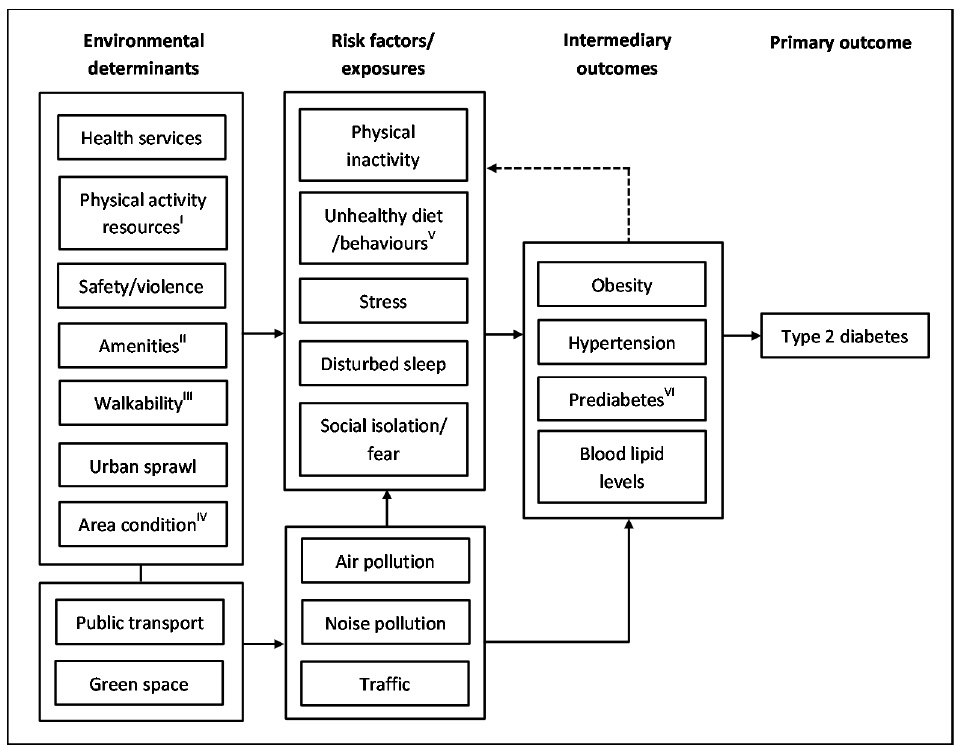
Figure 1. Schematic illustration of possible pathways through which environment impacts type 2 diabetes mellitus (T2DM) risk. Adapted from Poortinga [34], Northridge et al. [41], and Giles ‐ Corti et al. [42]. I include walking, jogging and cycling infrastructure, open spaces, trails, etc.; II include supermarkets, shops, food outlets, recreational and other facilities, etc.; III include street connectivity, density, land use, sidewalks, walkable destinations, etc.; IV include housing condition, design, aesthetics, etc.; V smoking and drinking; VI high blood sugar levels below the range of T2DM diagnosis, also referred to as impaired glucose tolerance (IGT) or impaired fasting glucose